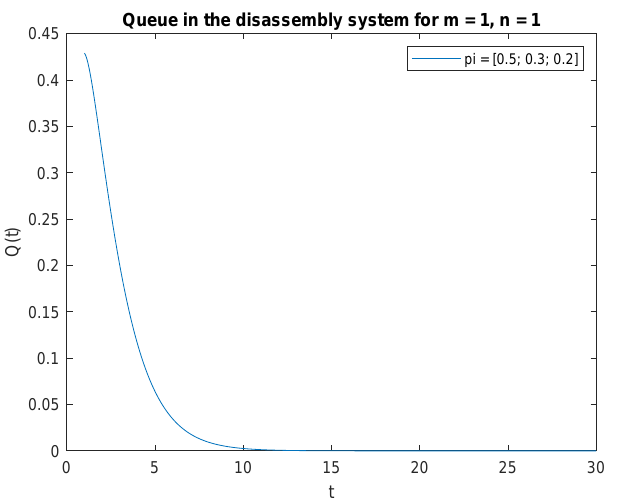
Figure 23. Impact of traffic load described by p i = { 0.2,0.6,0.2 } on P { X ( t ) = m = 1 | X ( 0 ) = n = 1 } for λ = 1.